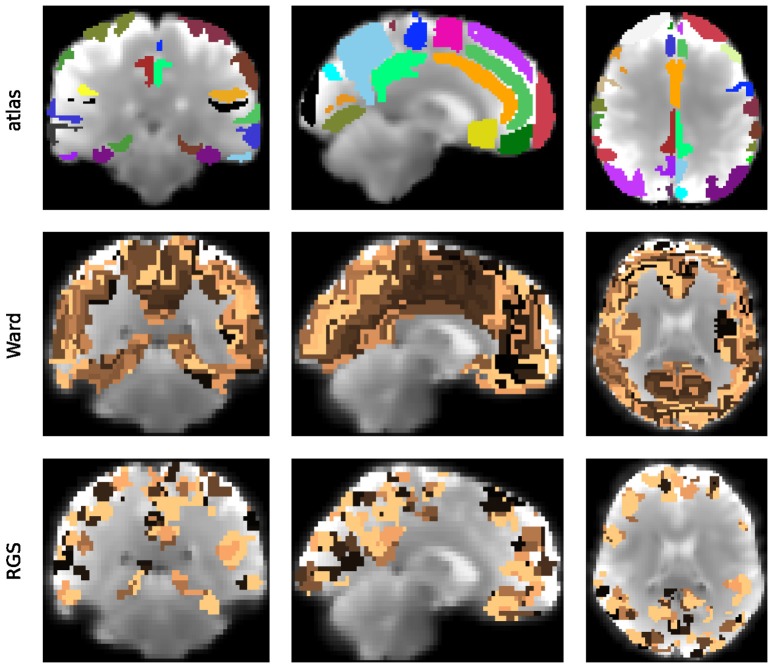
Clustering of the cortical functional image. Illustrated are the clustering outcome of the atlas (Upper Panel) and the Ward clustering (ward4, Middle Panel) and RGS (RGS1, Lower Panel) algorithms for frontal, sagital and horizontal brain sections (from left to right) of a randomly chosen healthy individual. Individual clusters are depicted by a randomly chosen individual color, for clustering parameters see Table 3.